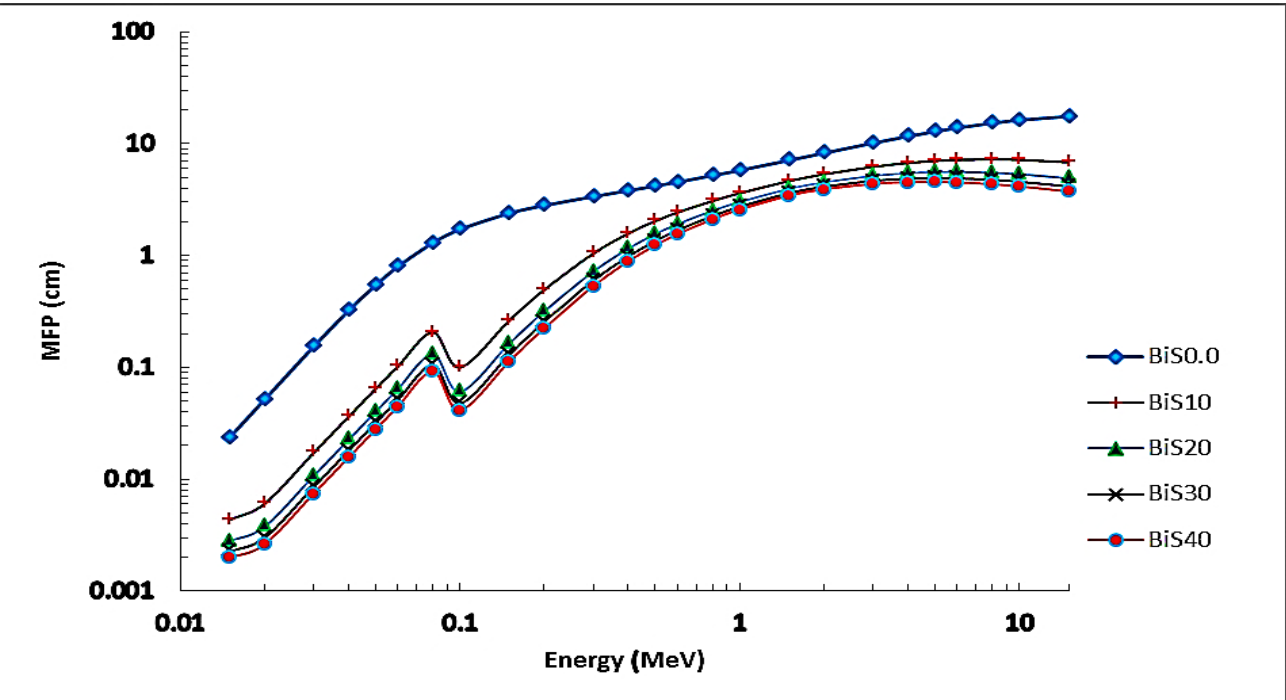
Figure 10. MFP depending on photon energy for all present glass samples.